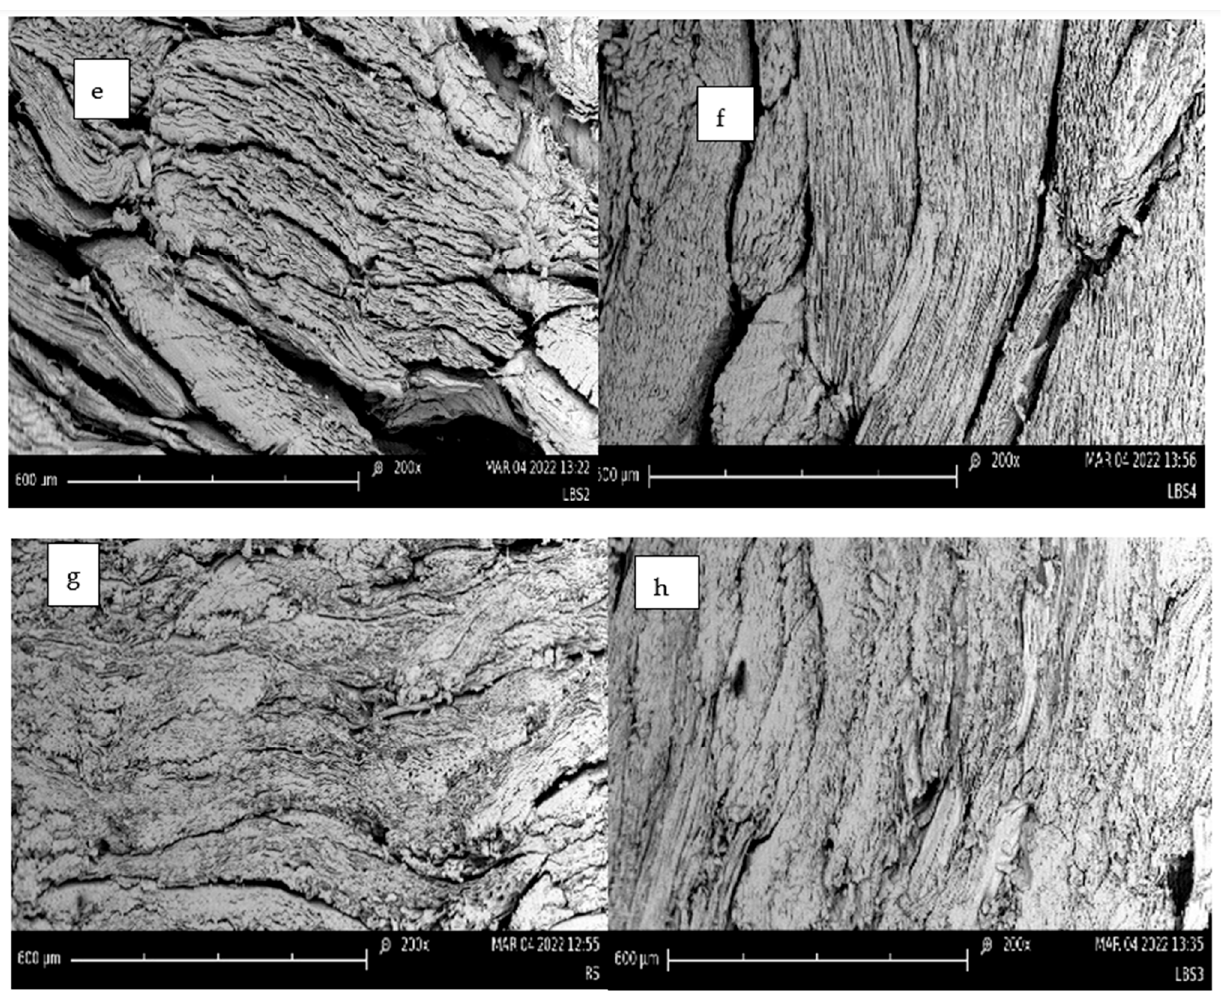
Figure 5. Scanning electron microscope images of the longitudinal cross-section of the untreated and steam-treated oat straw and sawdust pellets: ( a ) OS: NT (oat straw: untreated); ( b ) OS: T160 (oat straw: steam exploded at 160 °C); ( c ) OS: T180 (oat straw: steam exploded at 180 °C); ( d ) OS: T200 (oat straw: steam exploded at 200 °C); ( e ) SD: NT (sawdust: untreated); ( f ) SD: T160 (sawdust: steam exploded at 160 °C); ( g ) SD: T180 (sawdust: steam exploded at 180 °C); ( h ) SD: T200 (sawdust: steam exploded at 200 °C).